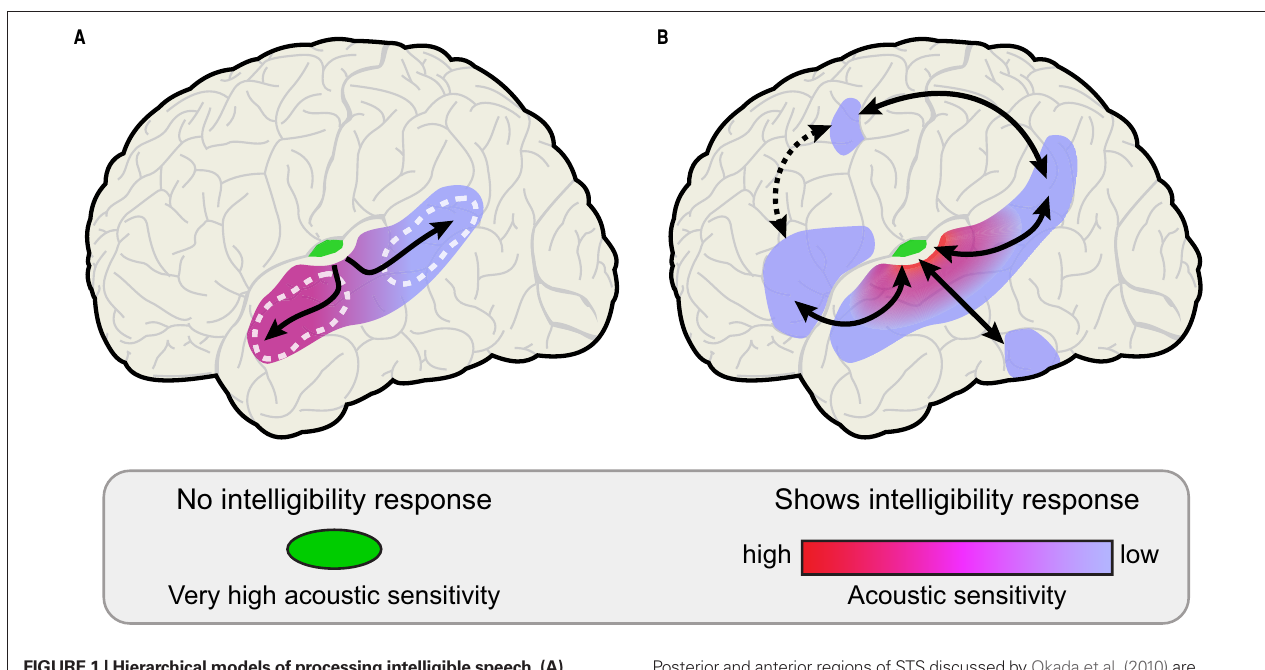
Figure 1 | Hierarchical models of processing intelligible speech. (A) Hierarchical processing in the temporal lobe, showing a posterior-anterior gradient in acoustic insensitivity moving away from primary auditory cortex.